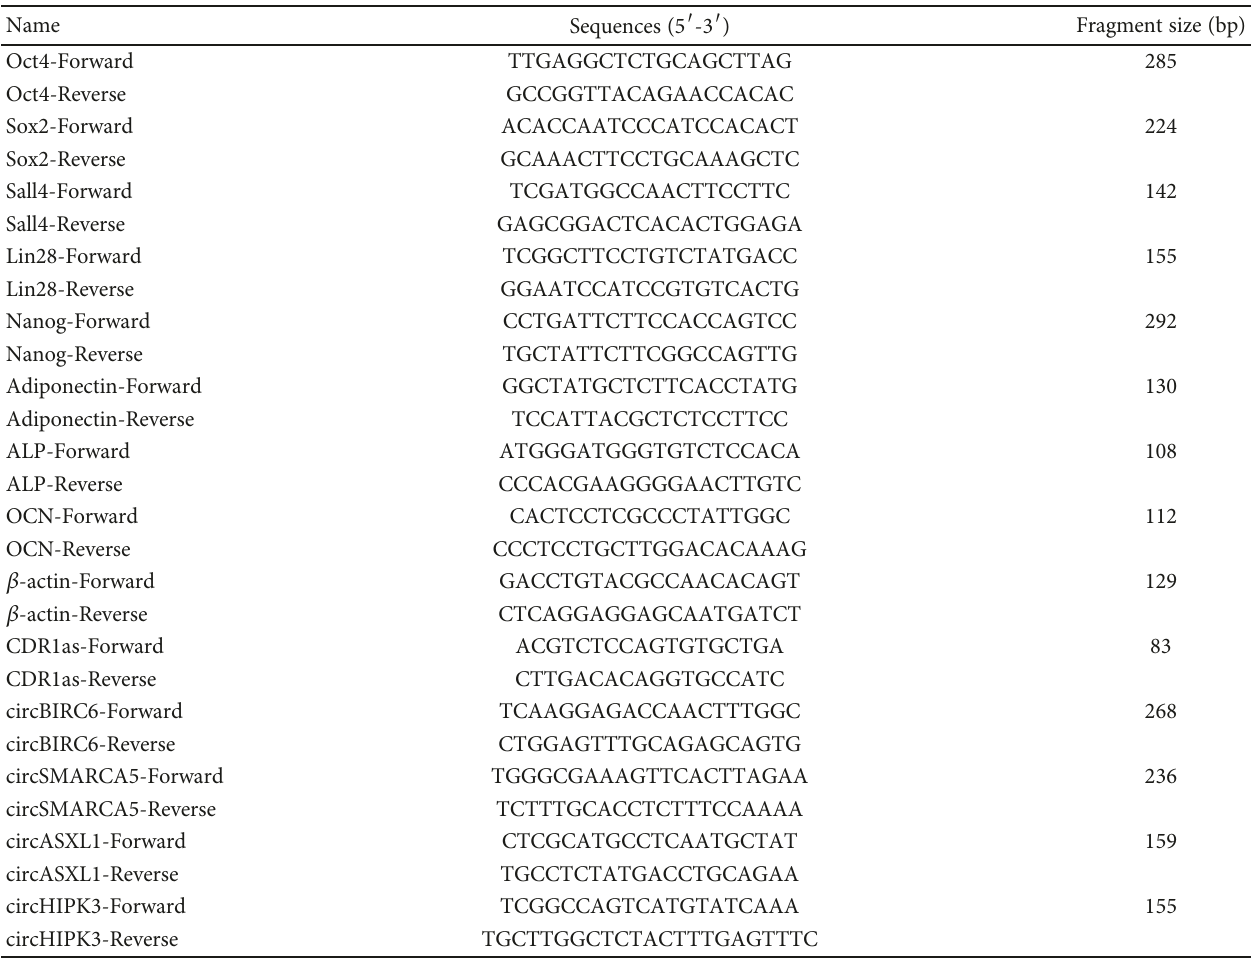
Table 1: Primers used in this